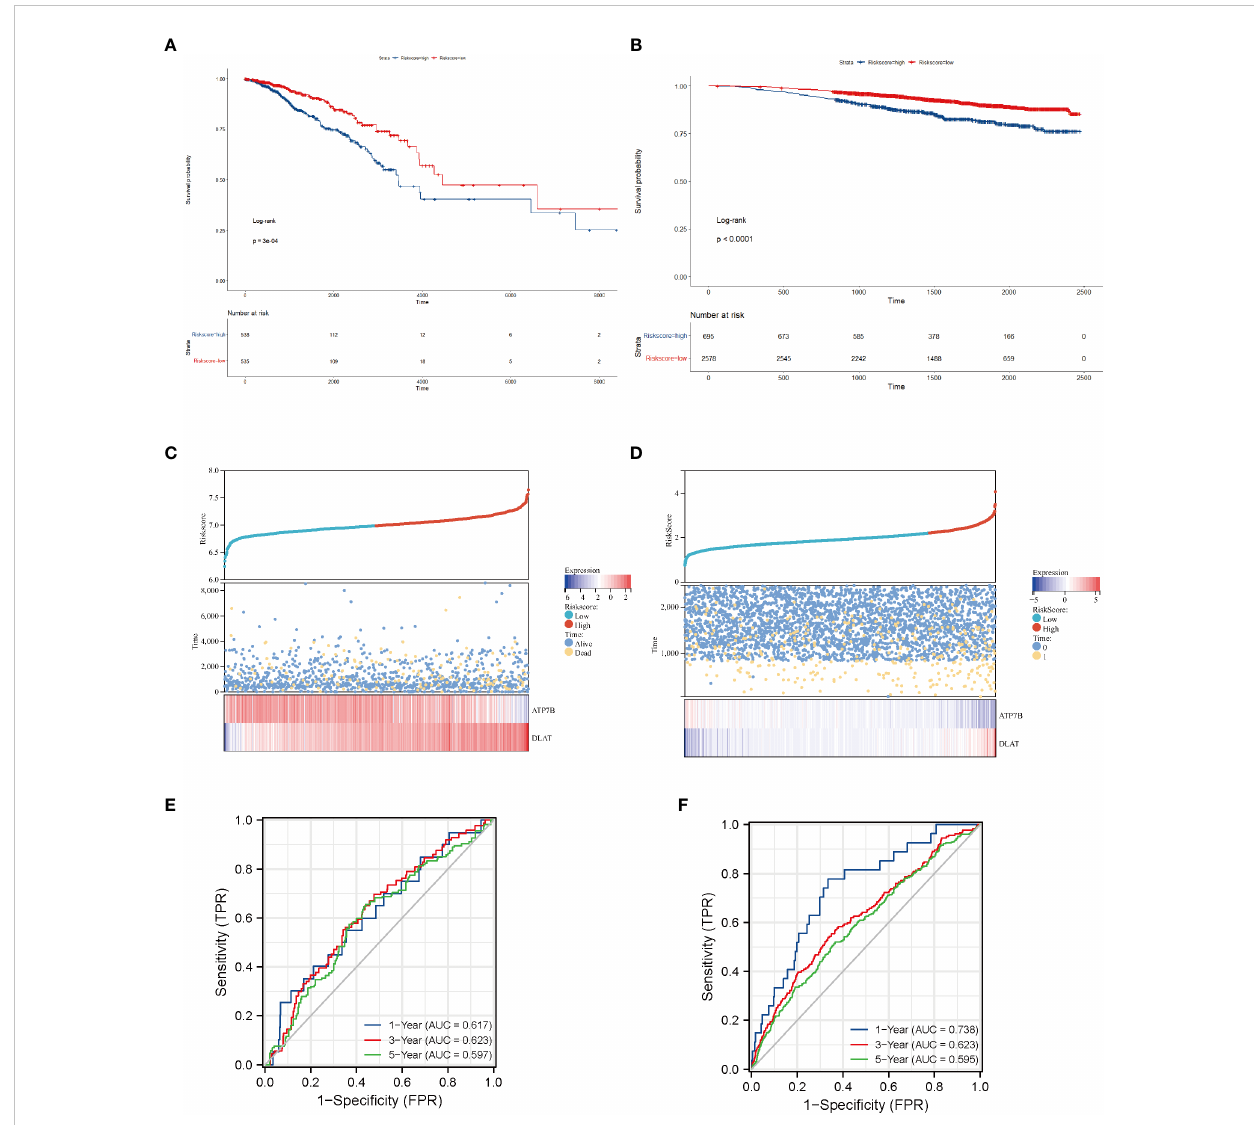
FIGURE 4 Survival analysis of breast cancer patients strati fi ed by the risk score of copper-related genes. The Kaplan – Meier curves of TCGA-BRCA samples (A) and a validating dataset GSE96058 (B) grouped based on the risk score of copper-related genes at the best cut-off point. The statistical method is the Log-rank test. The low-scoring group had a better survival probability in both TCGA-BRCA samples and GSE96058 samples. The dot and line diagram of risk score, state of survival and expression of ATP7B and DLAT from TCGA-BRCA samples (C) and a validating dataset GSE96058 (D) . Time-dependent ROC curve of the constructed model of TCGA-BRCA samples (E) and the validating dataset (F)